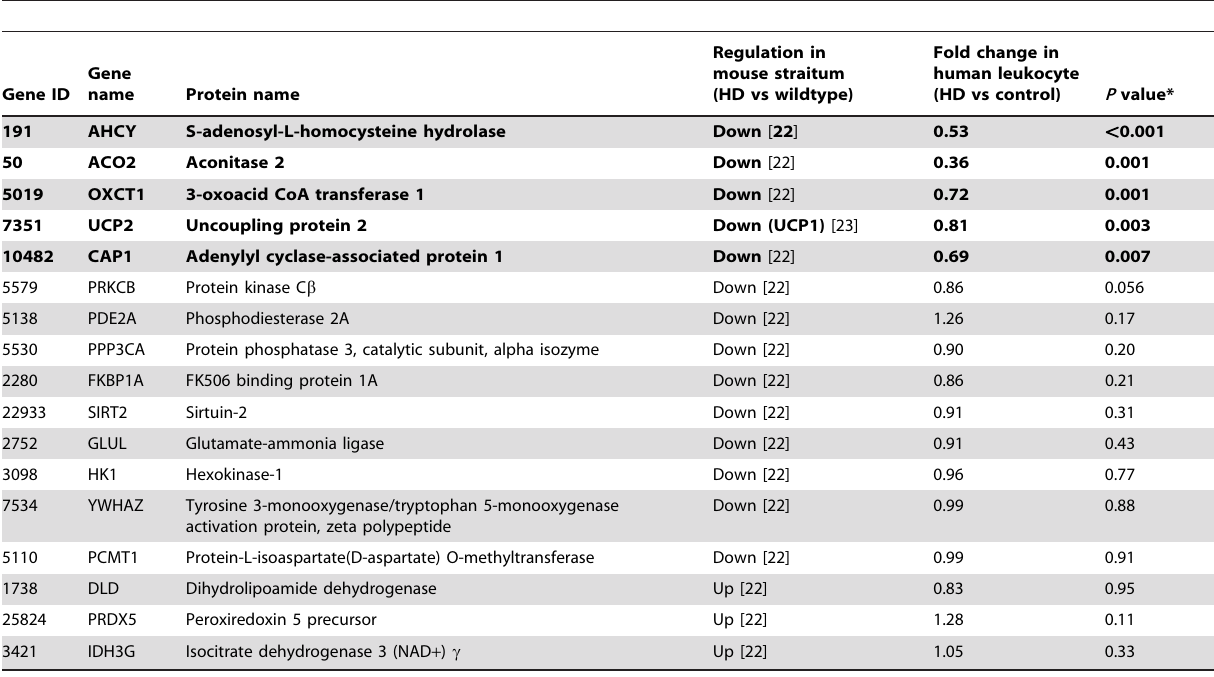
Table 1. Summarized RT-PCR validation results of the 17 genes in human